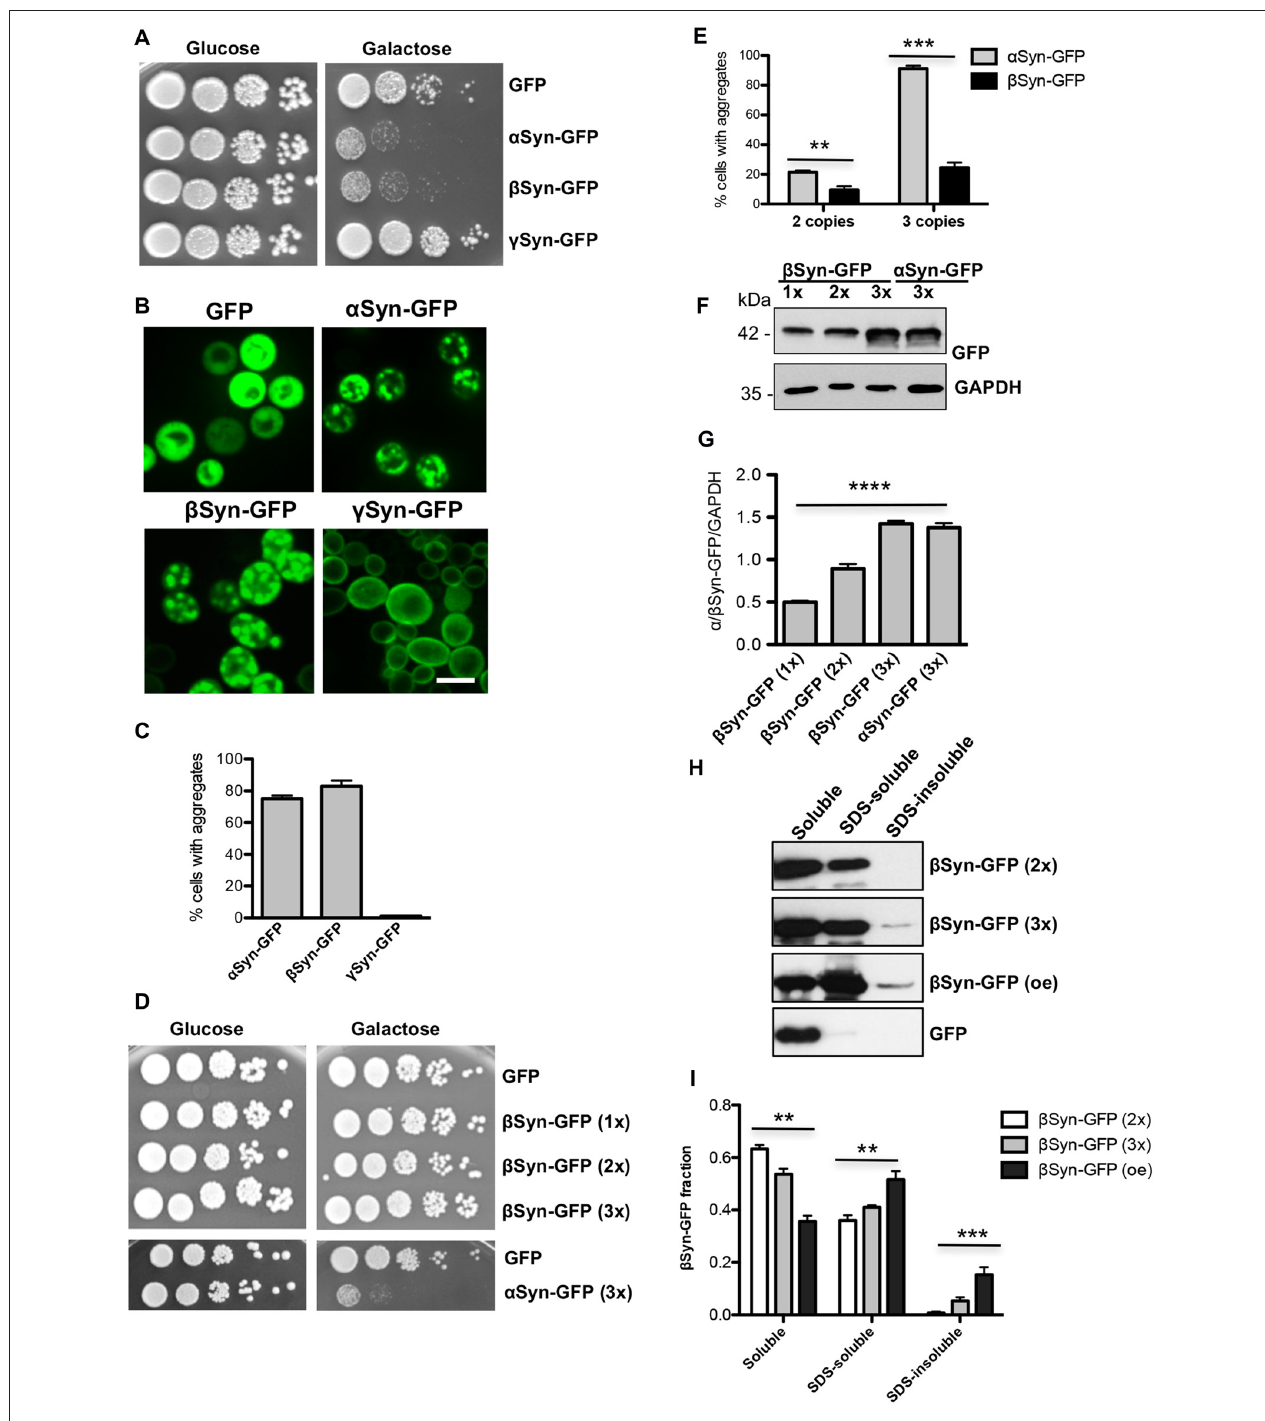
FIGURE 1 | β -synuclein ( β Syn)-GFP expression impairs yeast growth. (A) Wild type yeast cells (W303) were transformed with a high copy plasmid carrying α -synuclein ( α Syn)-GFP, β Syn-GFP and γ -synuclein ( γ Syn)-GFP under the control of GAL1 . GFP expressing cells, expressed from the same promoter, served as control. Yeast cells were spotted in 10-fold dilutions on selection plates containing glucose ( GAL1 promoter “OFF”) or galactose ( GAL1 promoter “ON”). (B) Live-cell fluorescence microscopy of yeast cells expressing GAL1 -driven synuclein isoforms from 2 µ plasmids. Yeast cells, pre-grown to mid-log phase, were induced in galactose-containing medium and examined for aggregates at 6 h of induction. Scale bar—5 µ M. (C) Aggregate quantification of yeast cells, expressing synuclein-GFP isoforms. For each strain, the number of cells displaying cytoplasmic foci is presented as percent of the total number of cells. For quantification